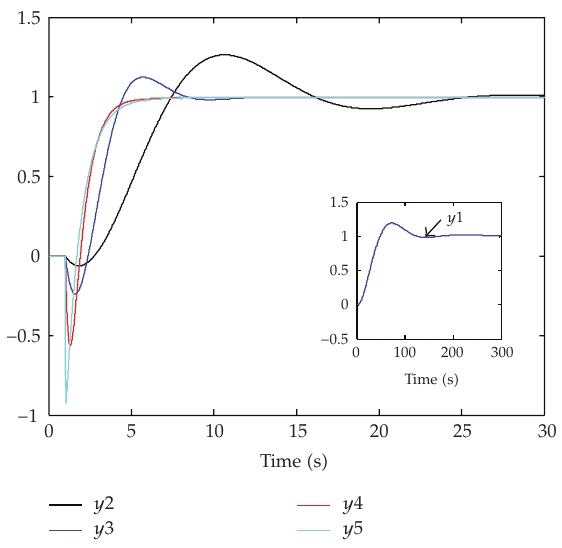
Figure 4: The influence of the location of the spectral zeros.